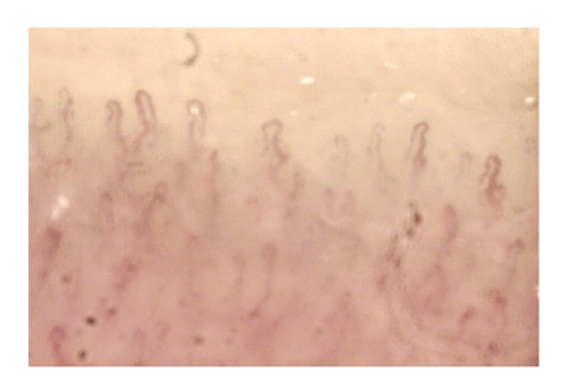
FIGURE1 Capillaroscopy in a patient with Adamantiades-Behçet disease (ABD) and Raynaud’s phenomenon showing non-specific microangiopathy. Normal number of capillaries/mm, tortuous capillaries, and filiform capillaries with minor dystrophies, pericapillary